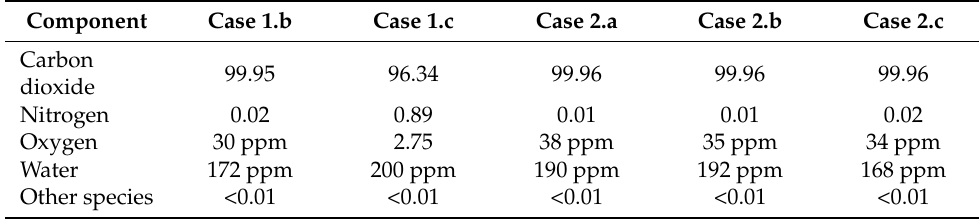
Table 4. Composition of captured CO 2